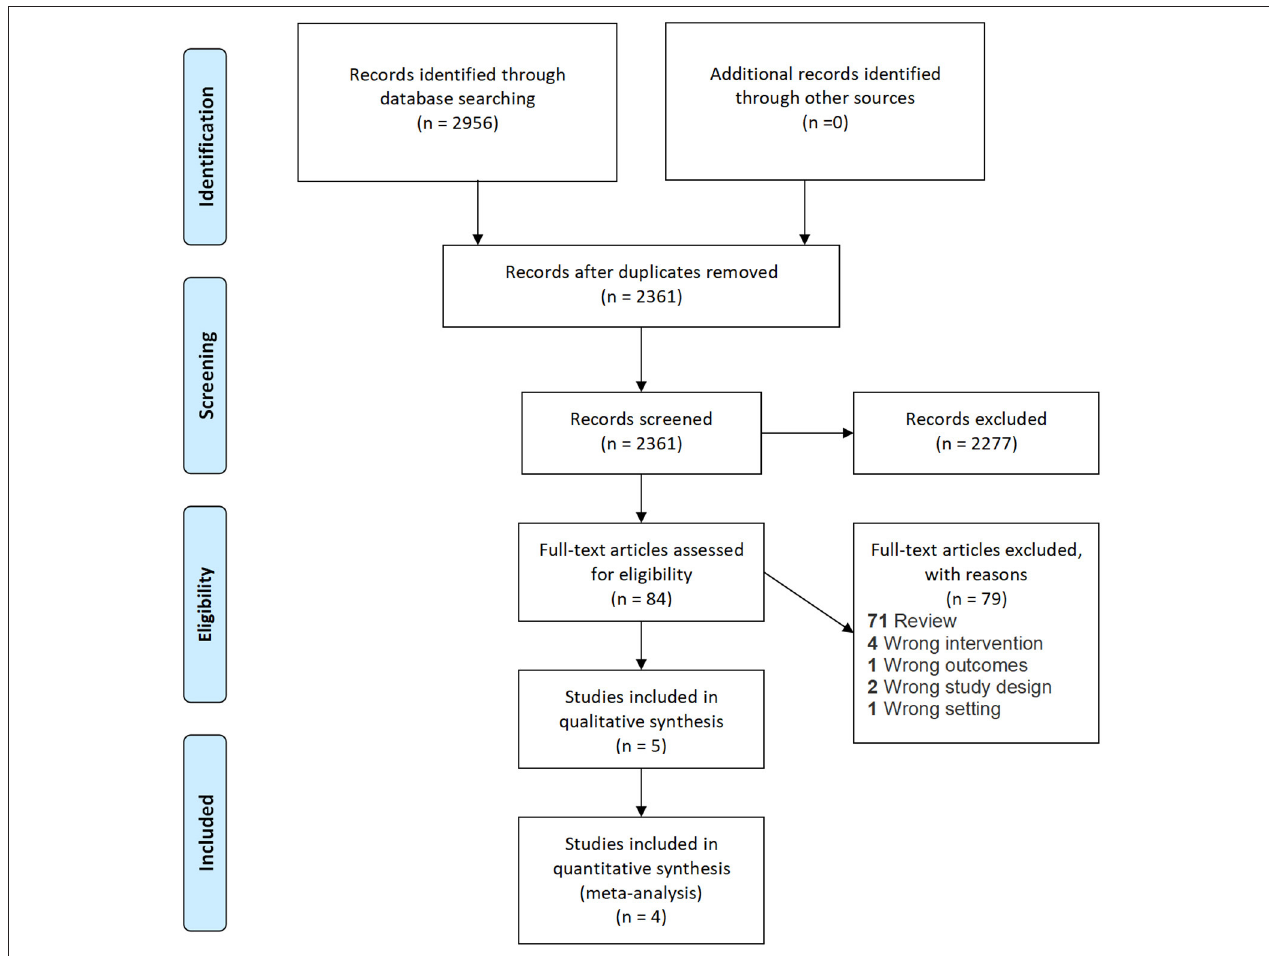
FIGURE 1 | PRISMA flow